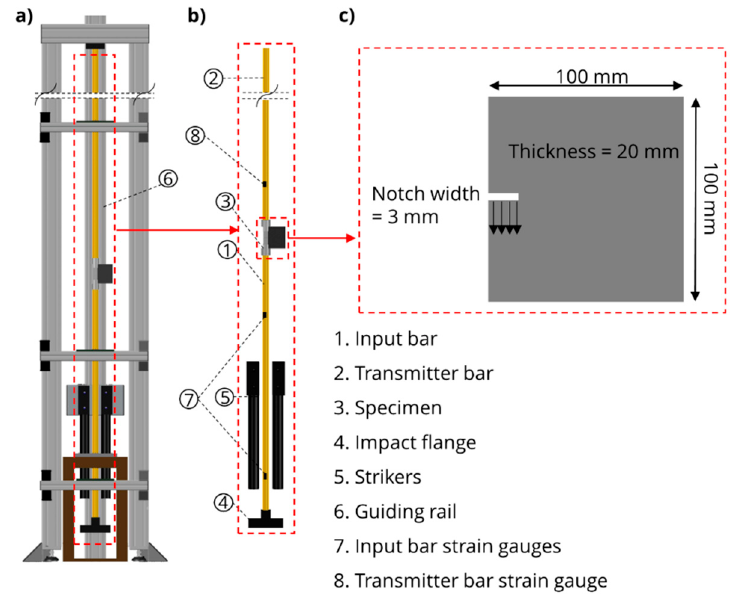
Figure 9. Experimental setup: Split-Hopkinson tension bar used for performing dynamic tests on compact-tension specimens: ( a ) Schematic view of the setup; ( b ) main components of the assembly; ( c ) specimen and its dimensions.